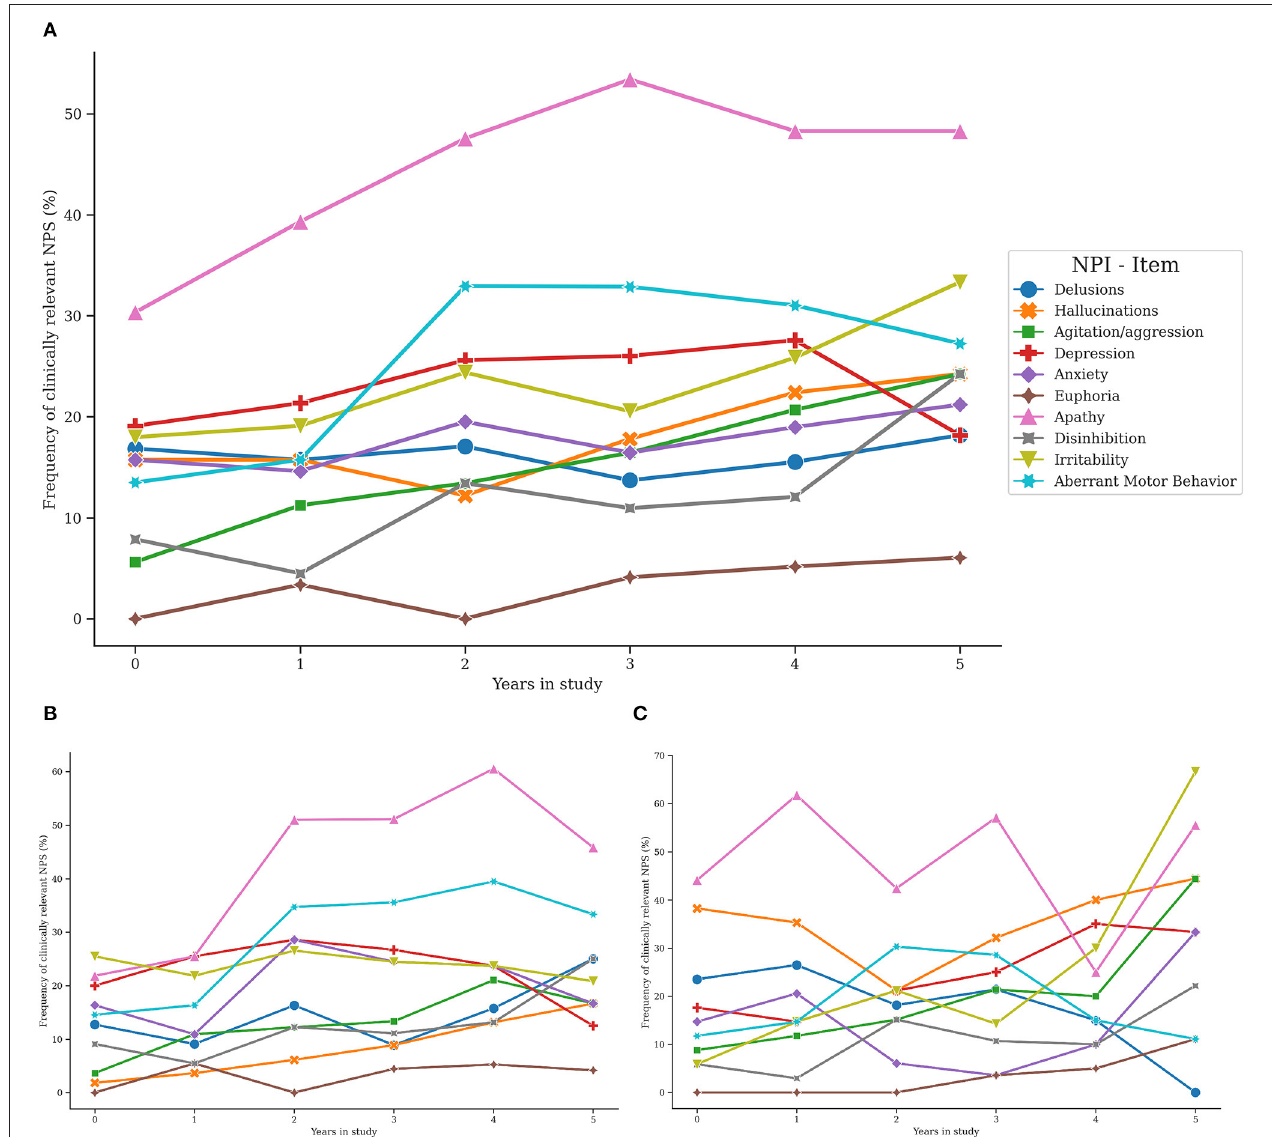
FIGURE 3 | Trajectories of clinically relevant neuropsychiatric symptoms in the total sample, AD and DLB groups. NPS, Neuropsychiatric symptoms; NPI, Neuropsychiatric Inventory; BL, Baseline. Trajectories of clinically relevant NPS in the total sample (A) , the AD subgroup (B) , and the DLB subgroup (C) .